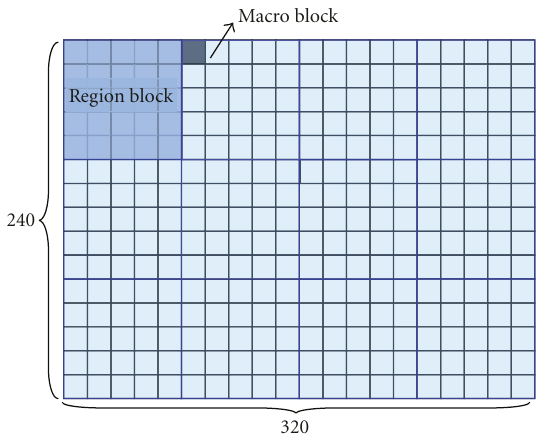
Figure 8: 80 × 80 region block partition for ROI-based streaming.